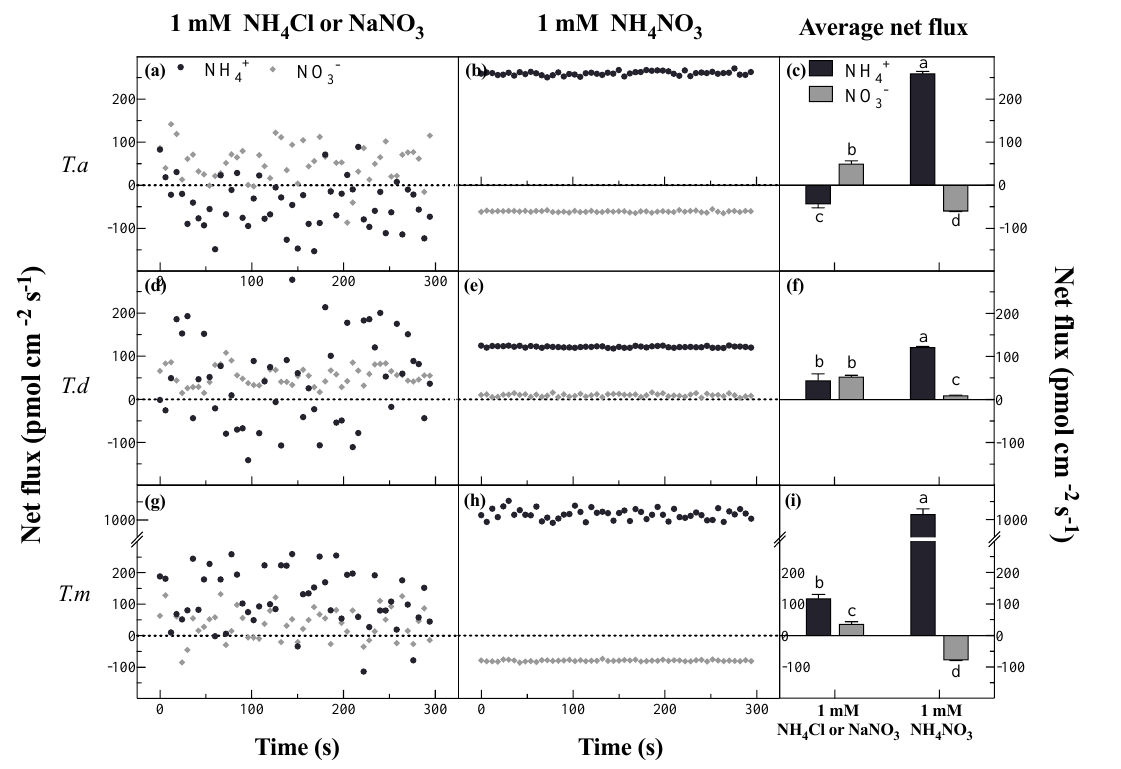
Figure 3. Net fluxes of NH 4+ and NO 3 − under single ( a , d , g ) and mixed ( b , e , h ) N forms, and the means of net fluxes of NH 4+ and NO 3 − ( c , f , i ). Bars indicate standard errors ( n = 8). Different letters indicate significant differences among the treatments according to Duncan’s Multiple Range Test at 5% level. T. a , T. d , and T. m represent T. ascendens , T. distichum and T. mucronatum , respectively. 3.3. Net NH 4+ , NO 3 − and H + Fluxes under Different N Concentrations Except for T. ascendens exposed to 1.0 mM NH 4 Cl, all three species showed a tendency for net NH 4+ influx when fed with 0.1 or 1.0 mM NH 4 Cl (Figure 4a). Additionally, the net influx of NH 4+ in T. ascendens was significantly greater ( p < 0.05) than those in the other two species under 0.1 mM NH 4 Cl (Figure 4a). Compared to 0.1 mM NH 4 Cl, net influx of NH 4+ was promoted by 2.40 and 2.84 times under 1.0 mM NH 4 Cl treatment in T. distichum and T. mucronatum , respectively (Figure 4a). Apart from T. ascendens and T. distichum treated with 0.1 mM KNO 3 , all the plants displayed a tendency for net NO 3 − influx when supplied with